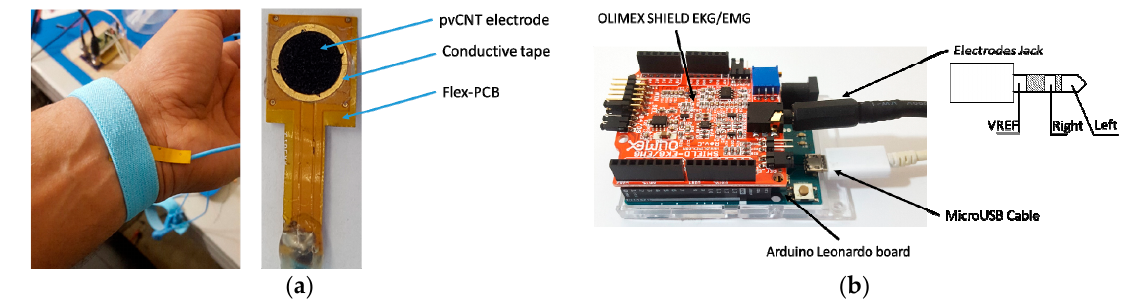
Figure 4. In vivo electrocardiogram (ECG) signal capture setup. ( a ) The pvCNT setup attached to the left arm. ( b ) The SHIELD_EKG_EMG attached with the Arduino Leonardo board.